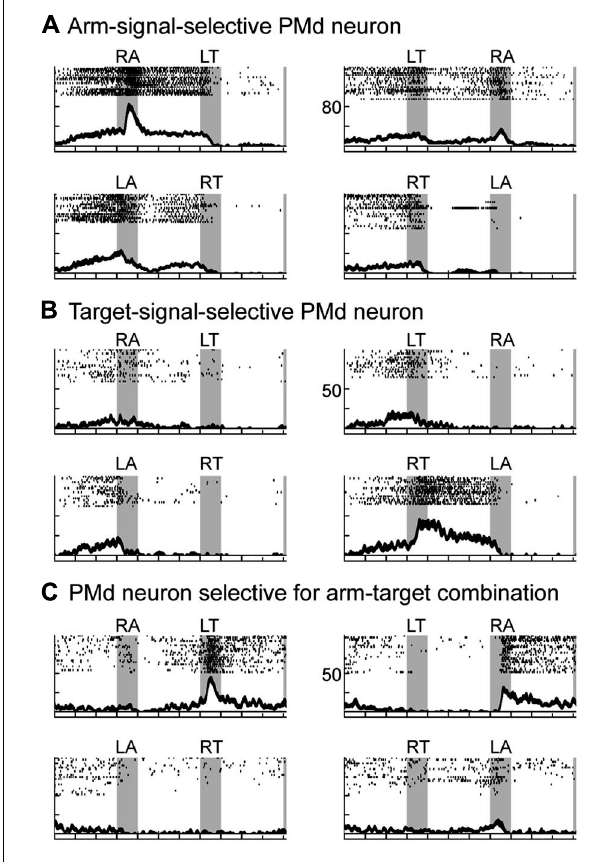
FIGURE 5 |Three types of neuronal activity in the PMd when monkeys planned a forthcoming reaching movement. (A–C) Three examples of PMd neuronal activity presented with raster displays and plots of spike density functions (SDFs). Gray areas (from left to right) represent when the first, second, and set cues were presented.Tick marks on the abscissa are at 400-ms intervals. First and second signals are shown at the top of each panel (RA, right arm; LA, left arm; RT, right target; LT, left target). SDFs (Gaussian kernel, σ = 20 ms, mean ± SE) appear below each raster display. Raster plots and SDFs were aligned to the onset of the first and second signal and the onset of the set cue.The ordinate represents the instantaneous firing rate. Of the eight possible sequences of first and second cues (four instructions × two presentation orders), only four are illustrated. (A) Activity of this PMd neuron was greater when cue 1 signaled the use of the right arm (RA). (B) Activity of this PMd neuron was greater when cue 1 signaled the right target. (C) Activity of this PMd neuron was observed when the combination of the two signals was RA (use of the right arm) and LT (left target). Activity was similar, regardless of the order of the two instructions (adapted from Hoshi andTanji,